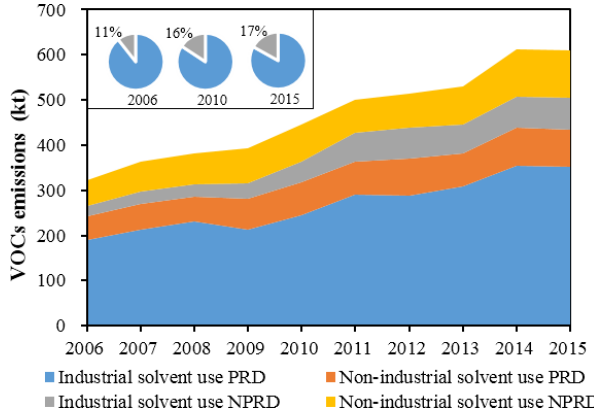
Figure 8. Trends of VOC emissions from solvent use by year. The blue, orange, gray, and yellow colors denote industrial source in PRD, non-industrial source in PRD, industrial source in NPRD, and non-industrial source in NPRD, respectively. The proportions of VOC emissions from industrial-solvent use in PRD to the total counterpart in GD are also shown using the pie graph in the top left